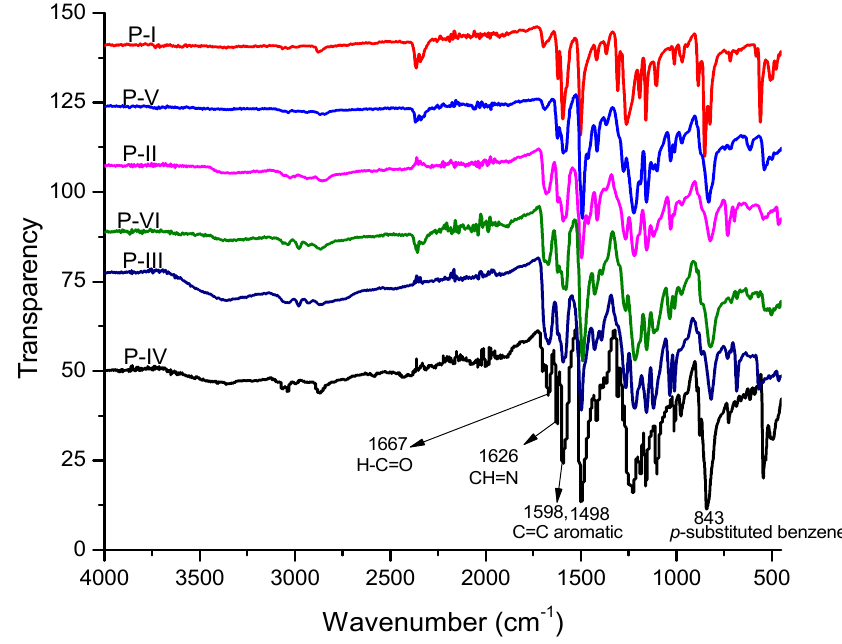
Figure 6. FT-IR spectra of polyazomethines. The spectra are shifted along the direction of intensity for clarity.